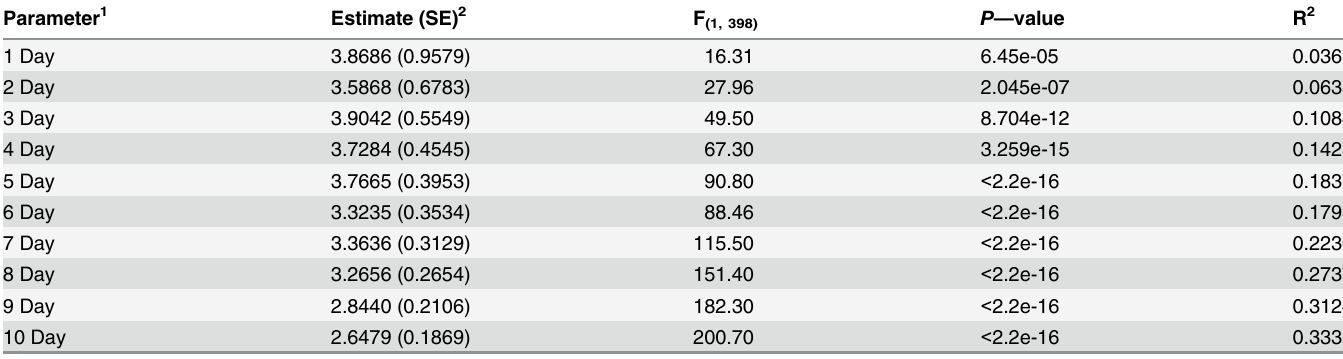
Table 1. Predicting total lifetime reproductive success from daily cumulative